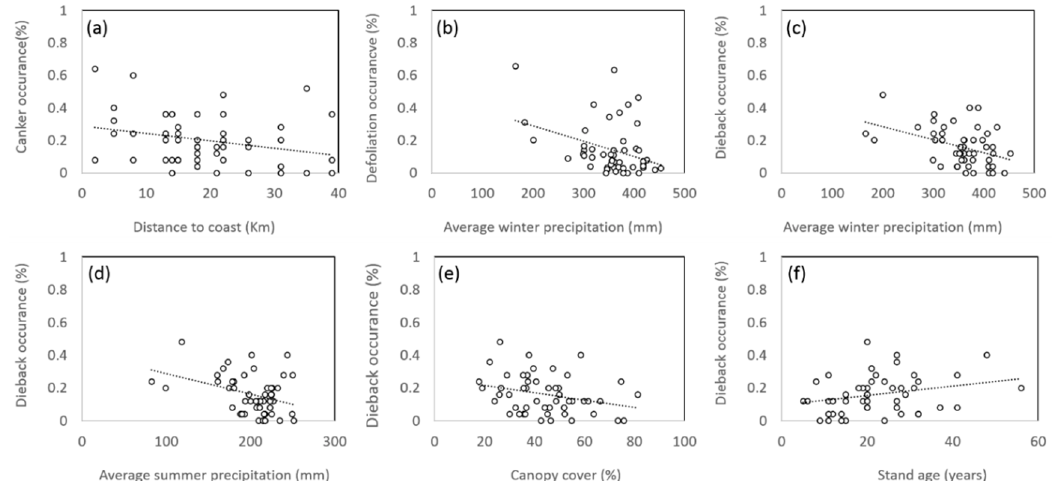
Figure 6. Plots of the key predictor variables, for Canker : ( a ) distance to coast; for Defoliation : ( b ) average winter precipitation; and for Dieback : ( c ) average winter precipitation, ( d ) average summer precipitation, ( e ) canopy cover, and ( f ) stand age. Table 3. The variables with a significant (bold letters: p value < 0.05) and highest independent contribution as determined by hierarchical partitioning analysis and results of the randomization tests. Group of Variables Canker Defoliation Dieback